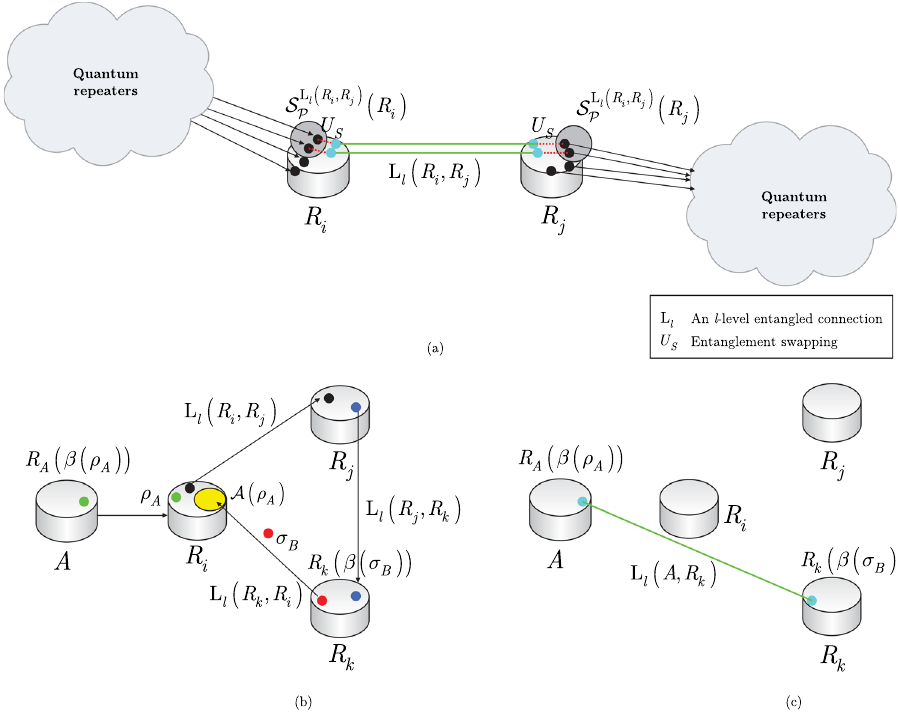
Figure 2. ( a ) A quantum Internet scenario with a set of incoming entangled connections S L l ( R i , R j ) P that traverse the entangled connection L l between quantum repeaters L l ( R i , R j ) S L l ( R i , R j ) R i and R j . The entangled states in the set S P ( R i ) of R i and in the set P of R j (depicted by gray circles) are to be swapped with the entangled state that forms L l . The entanglement swapping is performed by the entanglement swapping operator U S . The other incoming entangled states in the quantum L l ( R i , R j ) R i , R j are not elements of S repeaters that do not traverse L l P . ( b ) A deadlock situation in the entanglement swapping procedure in a quantum Internet setting. The aim of quantum node (cid:31) A is to share an entangled connection with the distant quantum repeater R k . The source node A generates an entangled pair and transmits one half, ρ A , to R i and keeps the other half, R A (β(ρ A )) . In R i , the set A (ρ A ) (depicted by a yellow circle) does not contain the target entangled system σ B from the target node R k for the swapping; therefore, R i generates an entangled pair (depicted by black dots) and shares an entangled connection L R i , R j with R j . Quantum repeater R j also generates an entangled pair (depicted by blue dots) and shares the R j , R k entangled connection L l with R k . Then, the target quantum node R k generates an entangled connection (cid:31) (cid:30) (depicted by red dots) and sends one half, σ B , to R i to form the entangled connection L l ( R k , R i ) , while it (cid:31) (cid:30) keeps the other half, R k (β(σ B )) . (c) Quantum repeater R i receives σ B and swaps it with ρ A to form the distant entangled connection L l ( A , R k ) . The deadlock in the entanglement swapping is caused by the fact that set A ( ρ A ) in R i does not contain σ B , so R i does not establish the entangled connection L l with R j , and R j does not establish the entangled connection L l with R k the low-priority nodes and the quantum repeaters, as well as to optimal resource balancing within the network. It is also assumed that the strongly-entangled structure has connections with many subnetworks. Resource allocation. In this section, the network situation is modeled via the definitions of “Strongly- S N entangled structure” section. A density matrix of R i is associated with an R (cid:31) (cid:30) I ingress quantum repeater of S N selected uniformly at random, thus a random routing is performed for the incoming query from the low- S N priority node R i to S N . Then, an arbitrary routing is preformed between the R (cid:31) (cid:30) E egress quantum repeater of